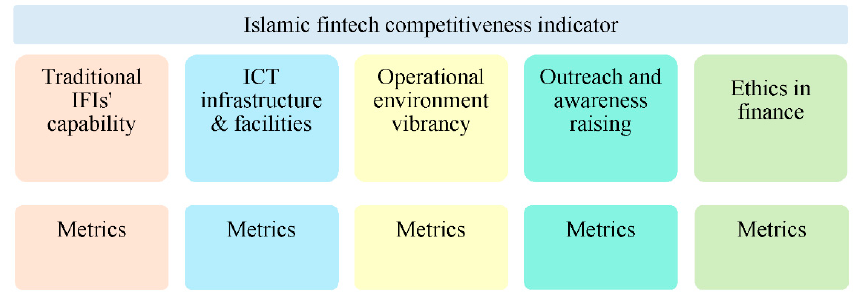
Figure 4. The structure of the Islamic fintech competitiveness indicator. The sub-indicators that we have introduced may still be characterised only